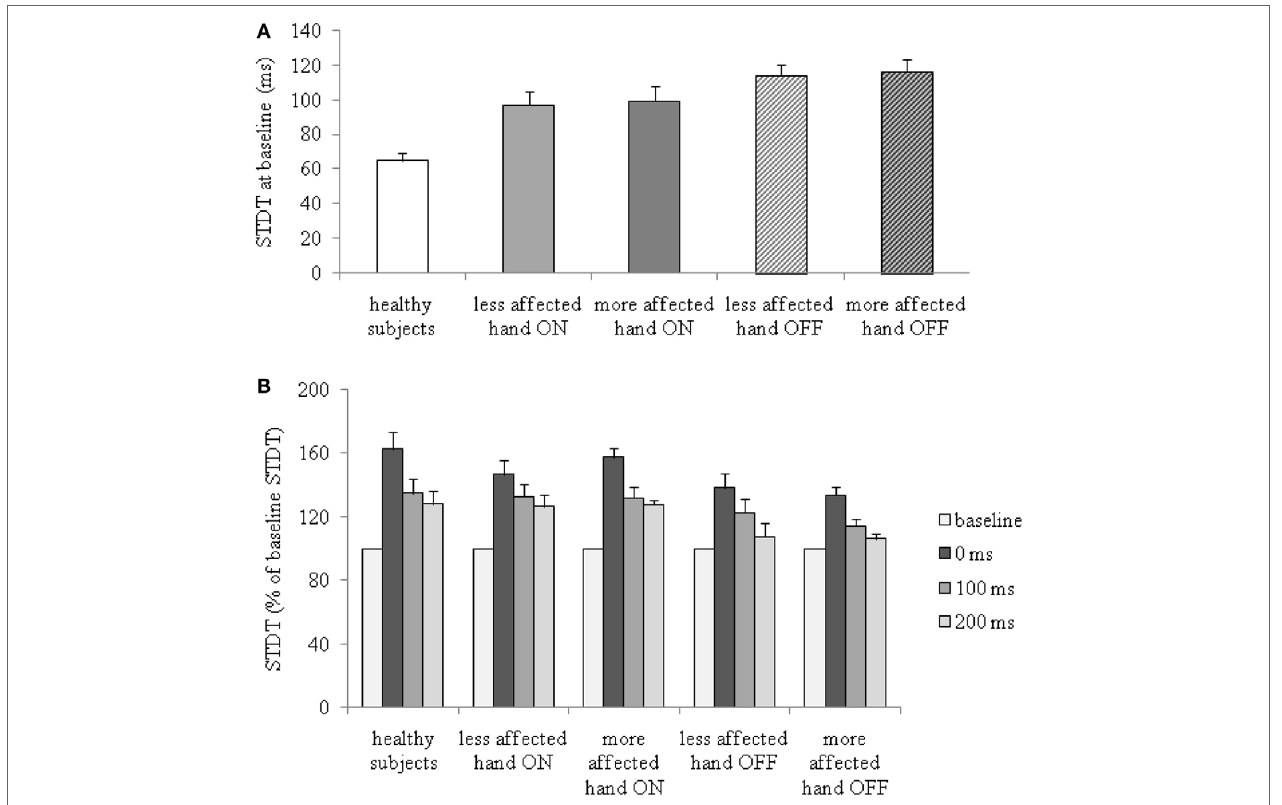
FigUre 1 | Changes in somatosensory temporal discrimination threshold (STDT) during index finger abductions in patients with Parkinson’s disease, in the ON and OFF therapy conditions, and in healthy subjects. (a) STDT at baseline (absolute values); (b) percentage changes of STDT during index finger